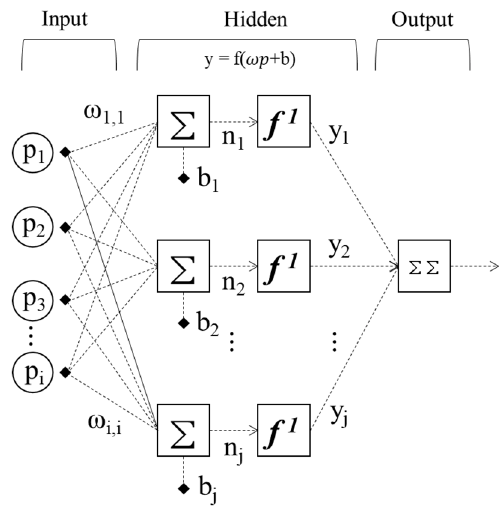
Figure 6. Procedure of artificial neural network from an input sample.